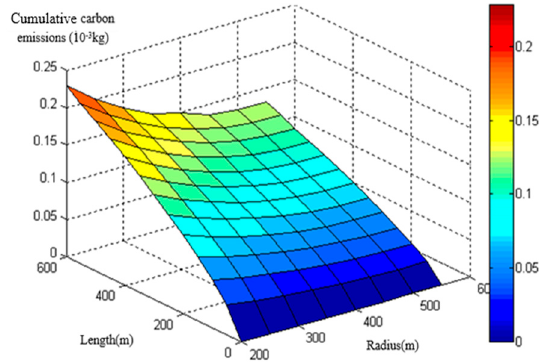
Figure 2. CO 2 emission database of heavy-duty diesel trucks at an initial speed of 30 km/h.